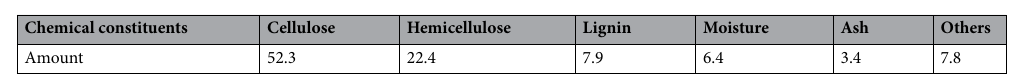
Table 1. Chemical constituents of treated kenaf fiber used in the